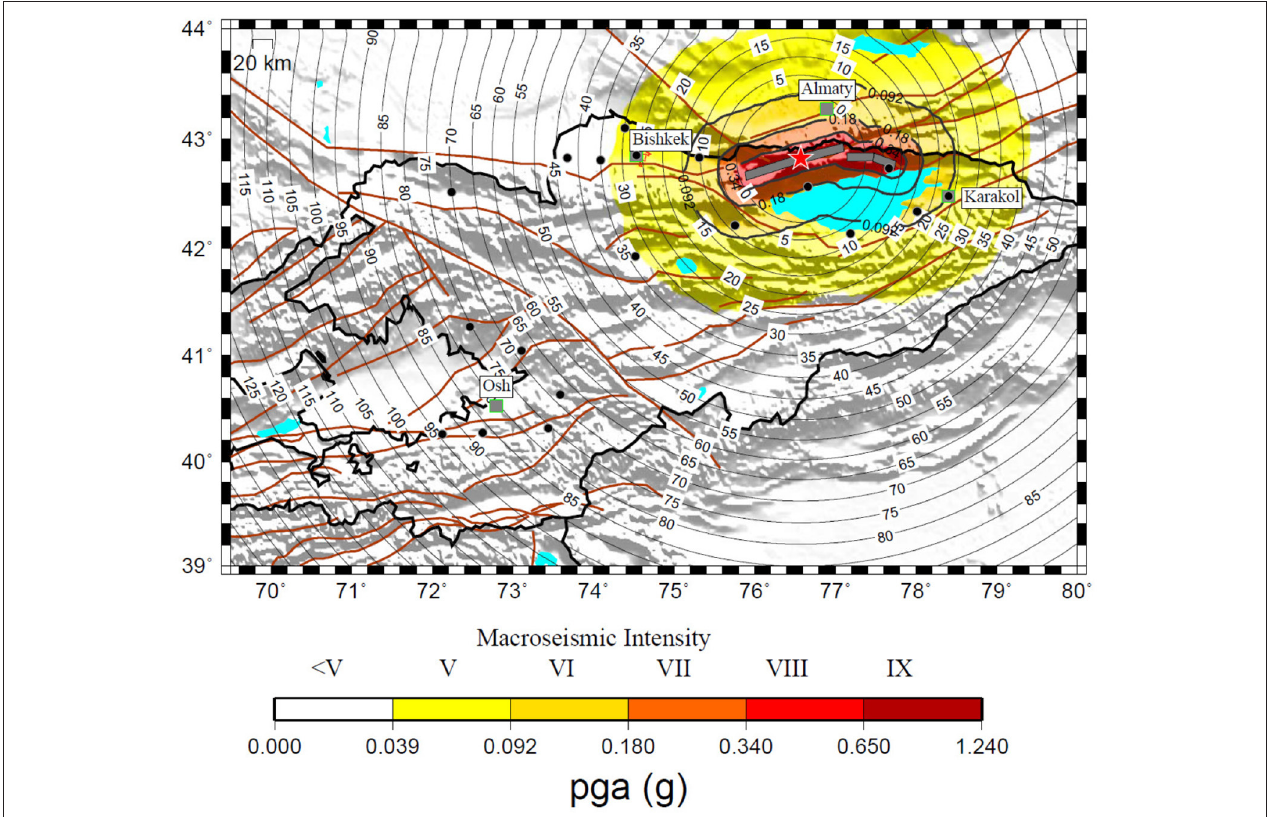
FIGURE 11 | The lead-times available across the Kyrgyz Republic and surrounding area for a repetition of the M 7.8 1911 Kemin earthquake (red star, Table 1 ), using the regional approach (black contour lines). The distribution of the calculated PGA (macroseismic intensity is found using the relationships of Wald et al., 1999) is shown by the color scale. Also shown are the main cities (gray squares) of the country (see Figure 1 ). The brown lines indicate the main tectonic alignments and faults existing in the